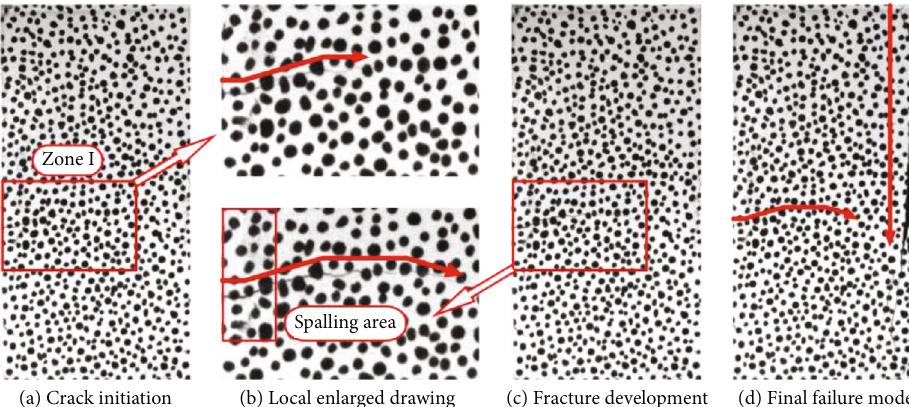
Figure 6: The surface fracture evolution process of specimen S2-3.